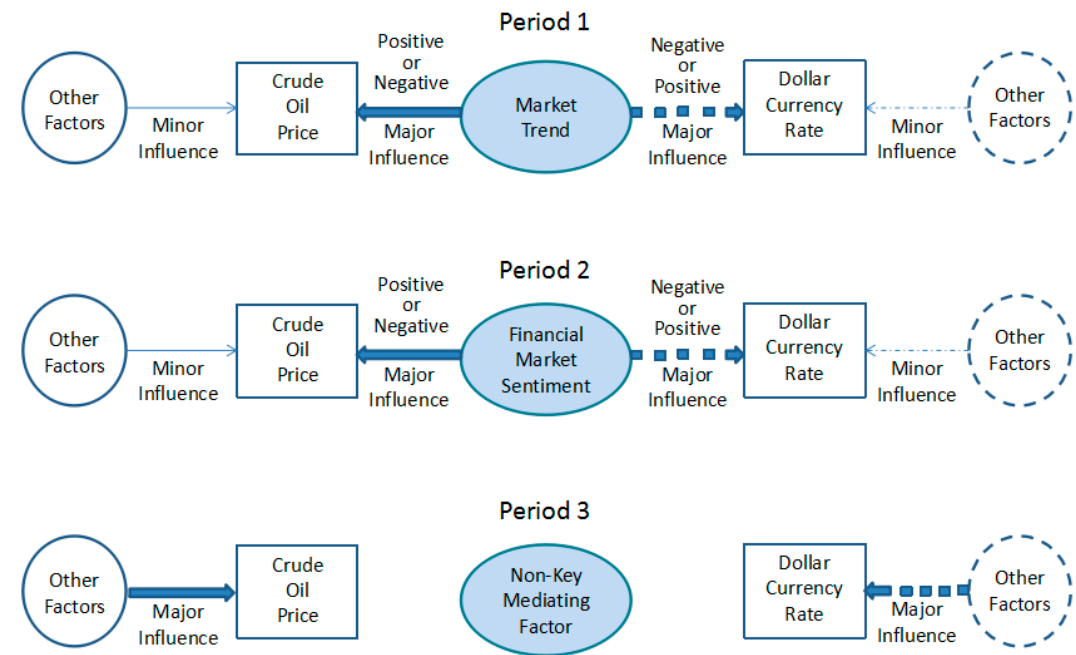
Figure 3. Mechanism diagram of ‘key mediating factors’ hypothesis.